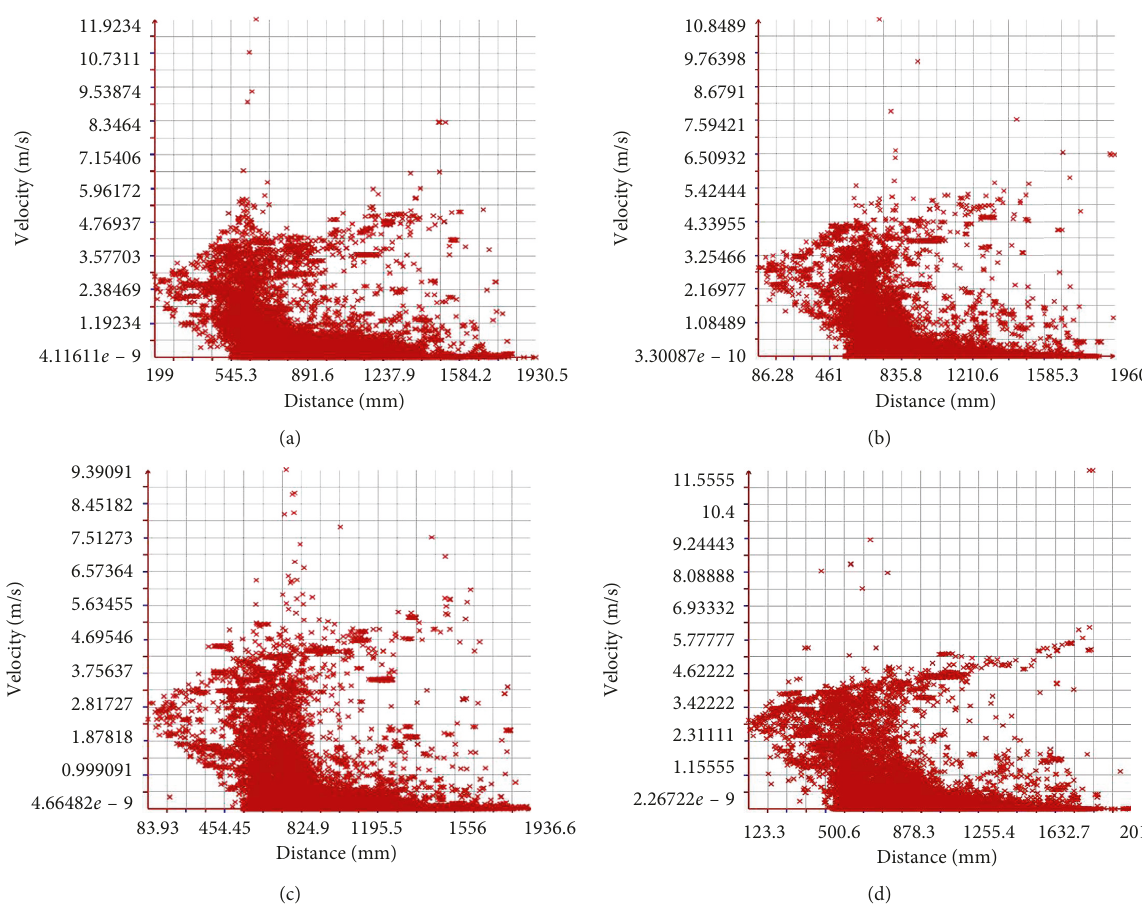
Figure 12: Distance vs. velocity of the coal particles. (a) B